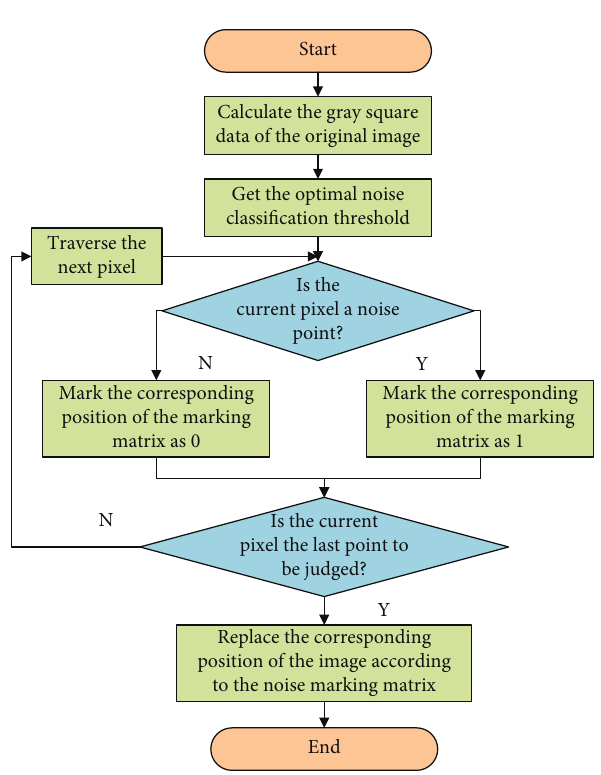
Figure 3: Flow chart of noise detection based denoising